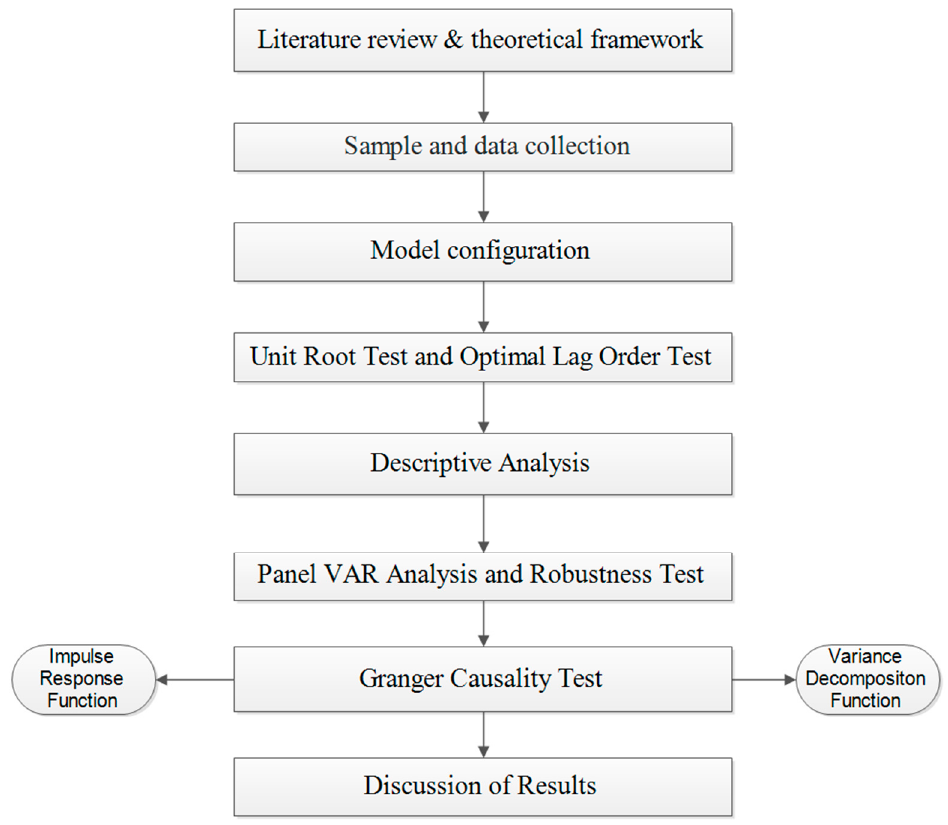
Figure 1. Procedure of the study.